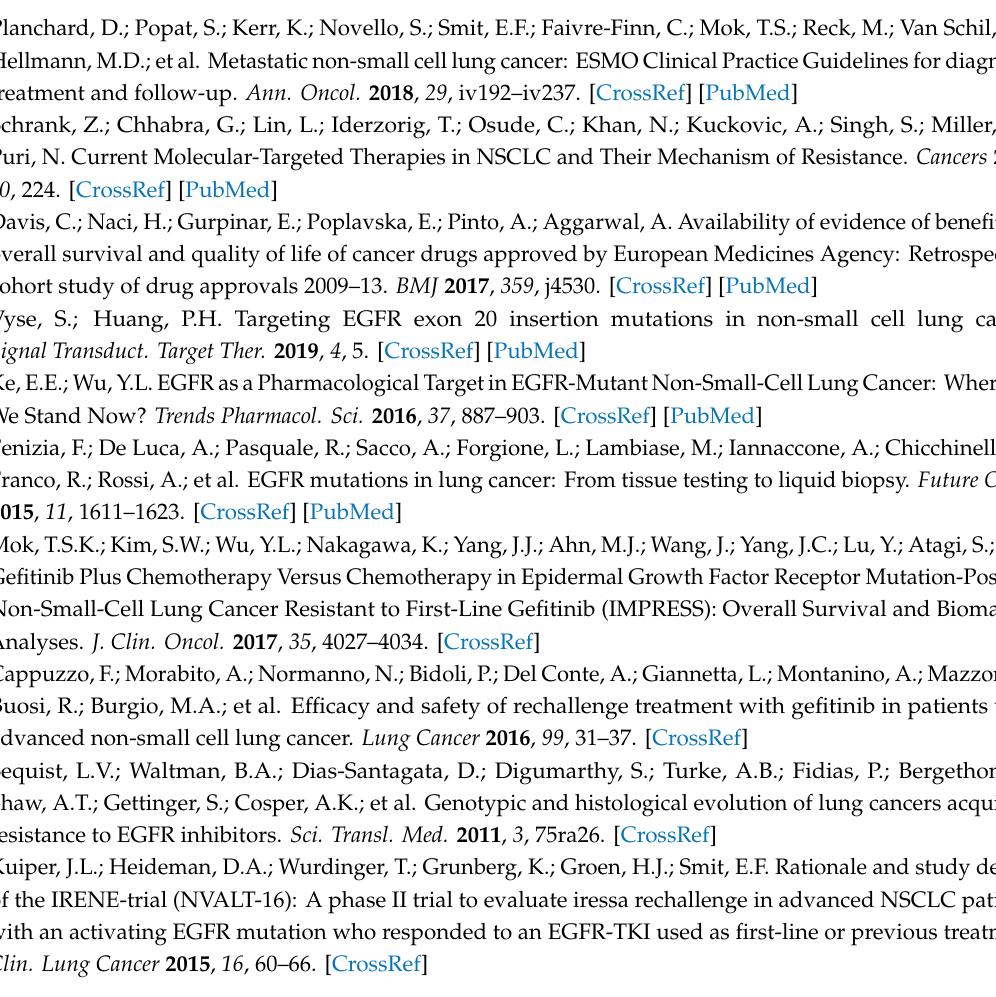
Table S1: Details on rechallenge with gefitinib for individual